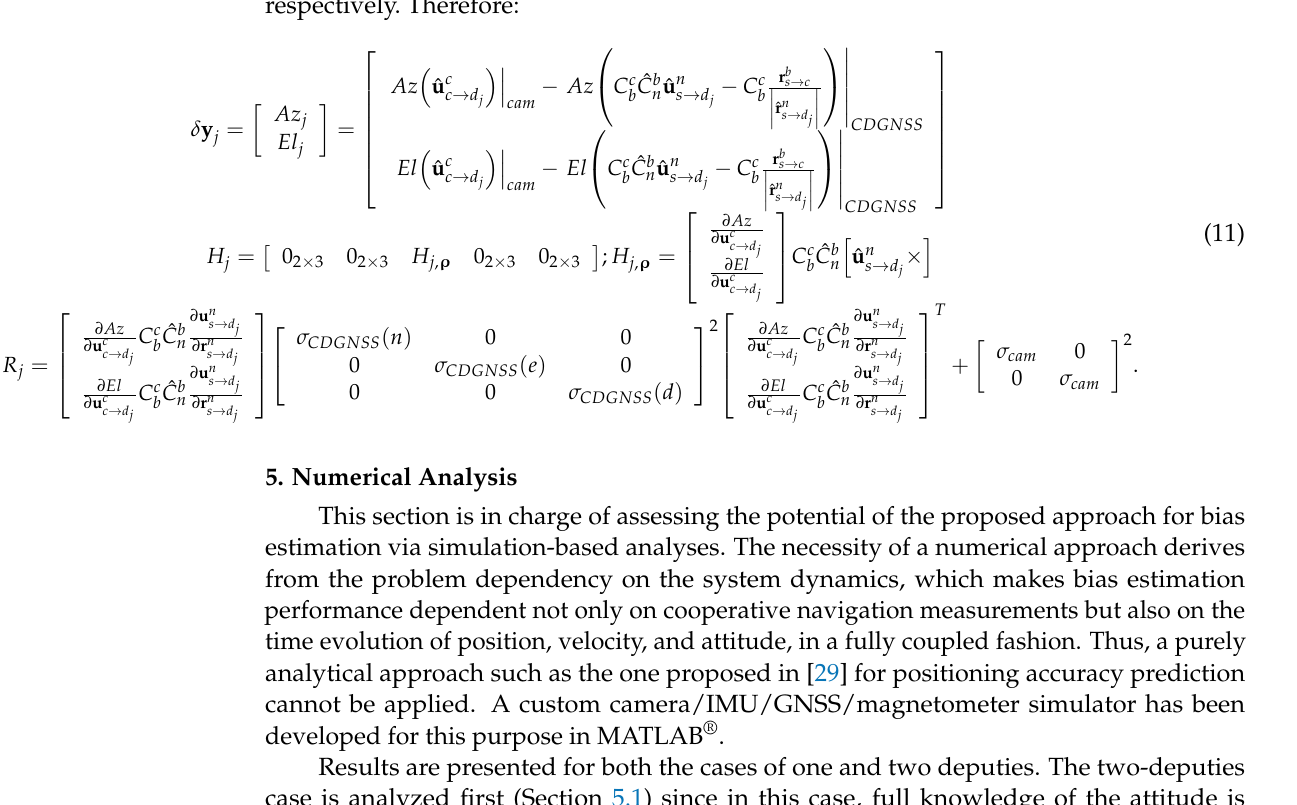
Table 1. IMU parameters [37].